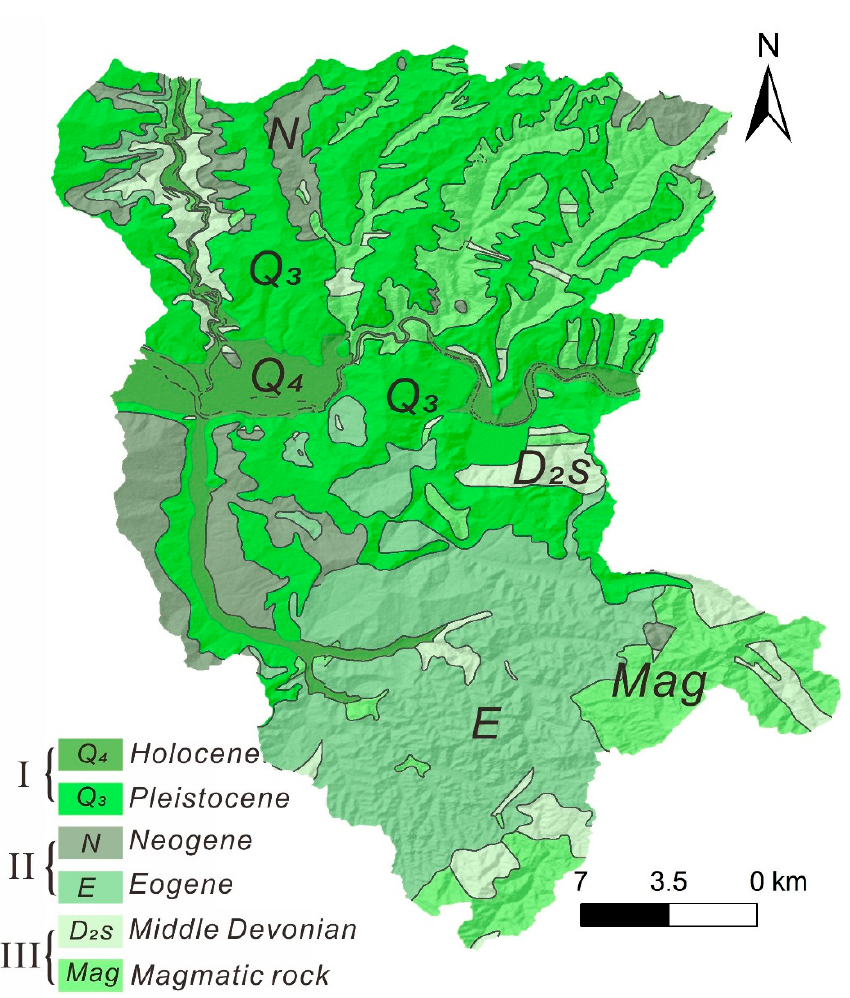
Figure 3. Geological map of the study area, obtained from 1:200,000 geological maps published by the China Geological Survey (http://dcc.cgs.gov.cn/);.